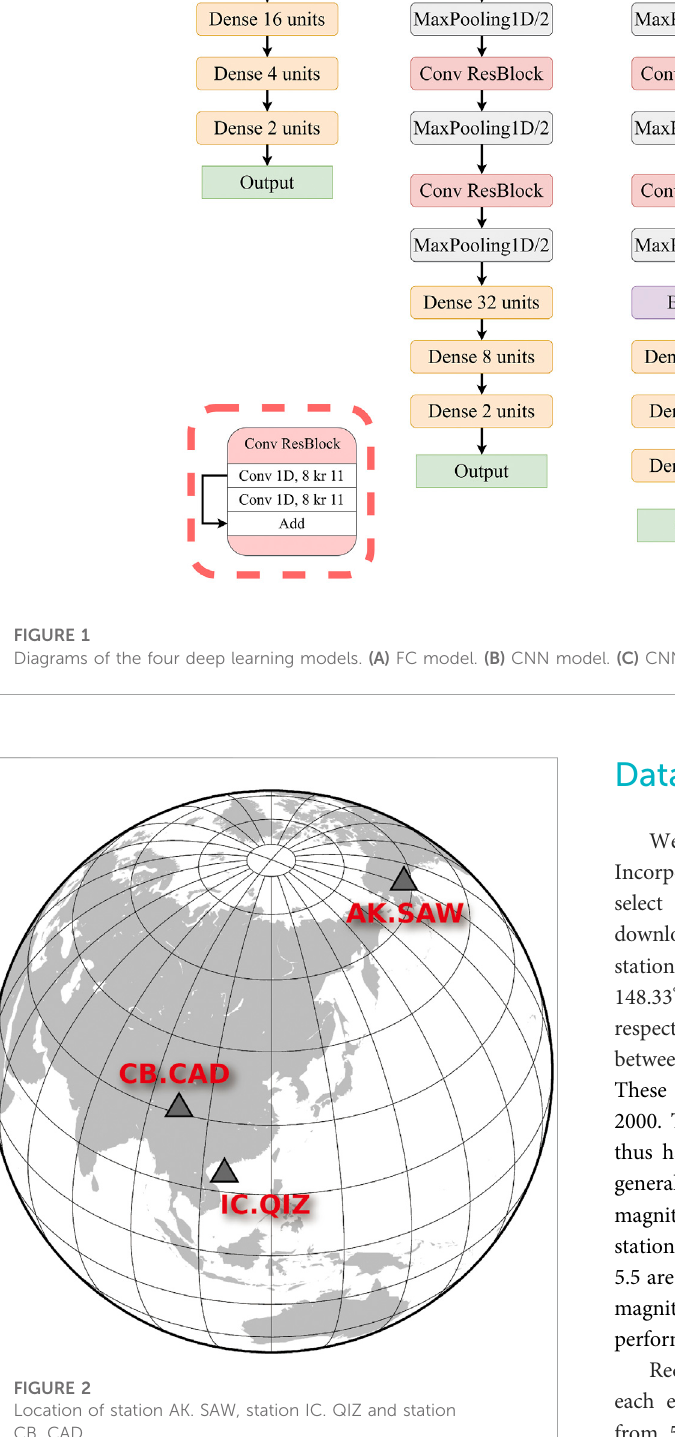
FIGURE 2 Location of station AK. SAW, station IC. QIZ and station CB.